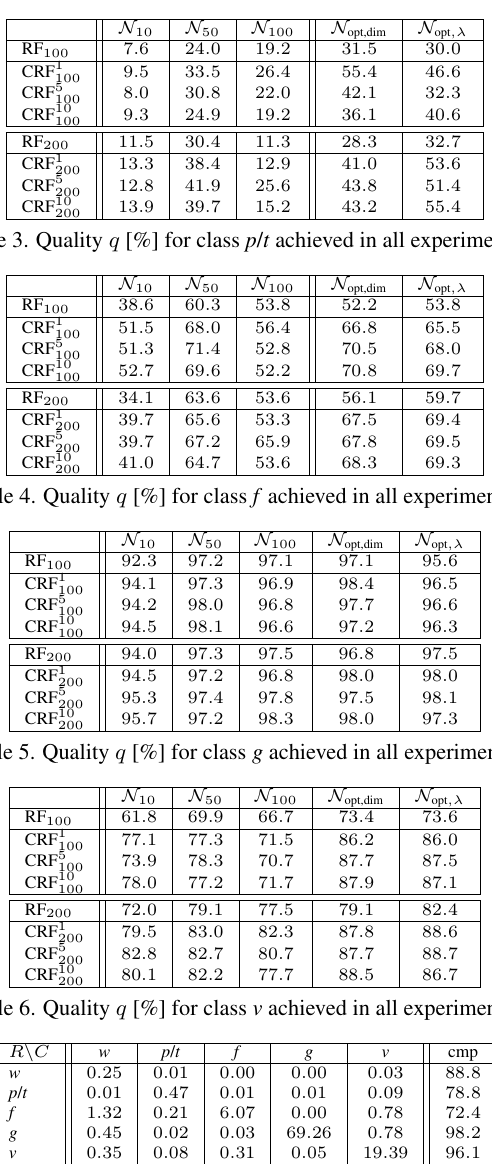
Table 2. Quality q [%] for class w achieved in all experiments.